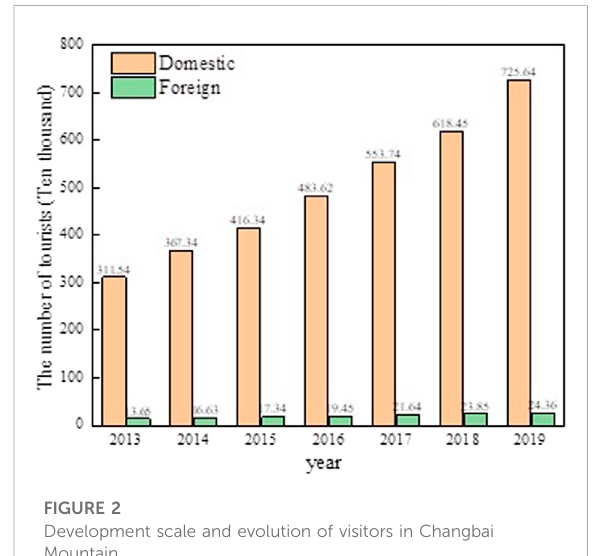
Development scale and evolution of visitors in Changbai Mountain.